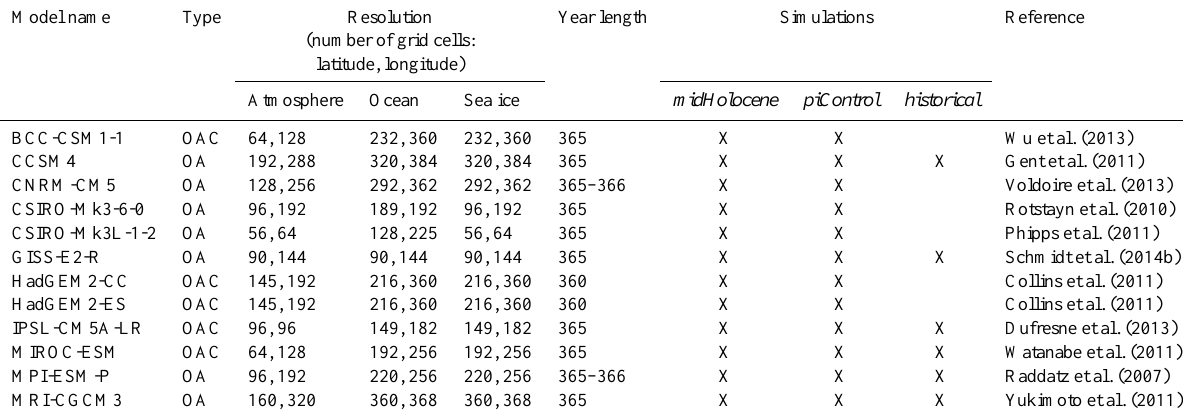
Table 1. Characteristics of the CMIP5 models used in these